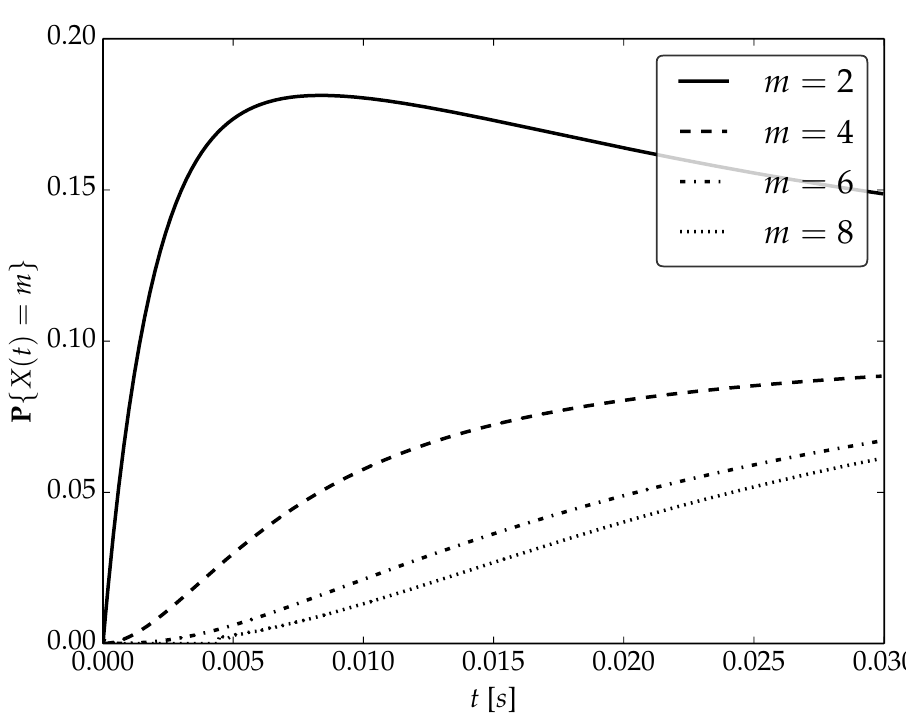
Figure 4. Transient distributions P { X ( t ) = m } for N = 2, batch distribution P 2 and ρ = 1.